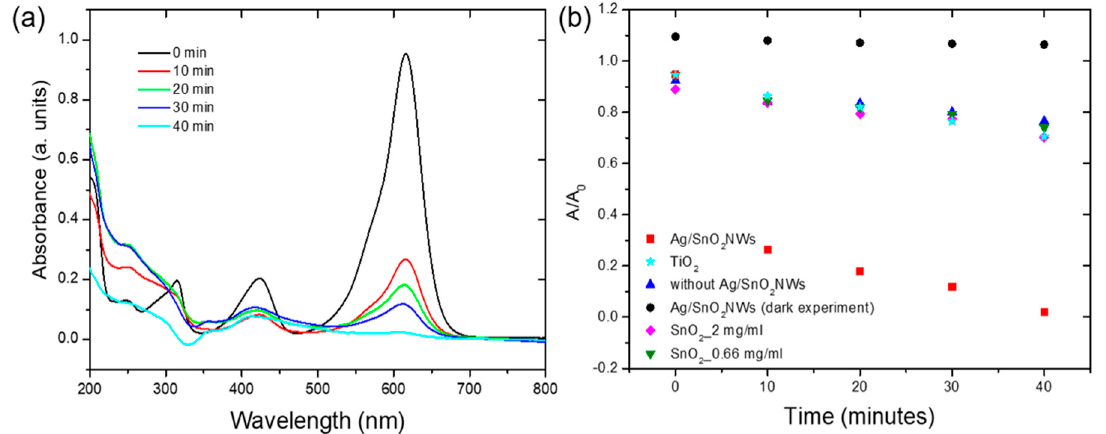
Figure 5. ( a ) The absorbance spectra of malachite green with Ag/SnO 2 NWs photocatalyst presence under 450 nm light irradiation. ( b ) The degradation of malachite green with 2 mg/mL of Ag/SnO 2 NWs catalyst ( ■ ), with no photocatalyst ( ▲ ), with 0.66 mg/mL of SnO 2 NPs ( ▼ ), 2 mg/mL of SnO 2 NPs ( ◆ ), and with 2 mg/mL TiO 2 catalyst ( ★ ) under 450 nm light irradiation and Ag/SnO 2 NWs without irradiation (dark experiment, ● ).